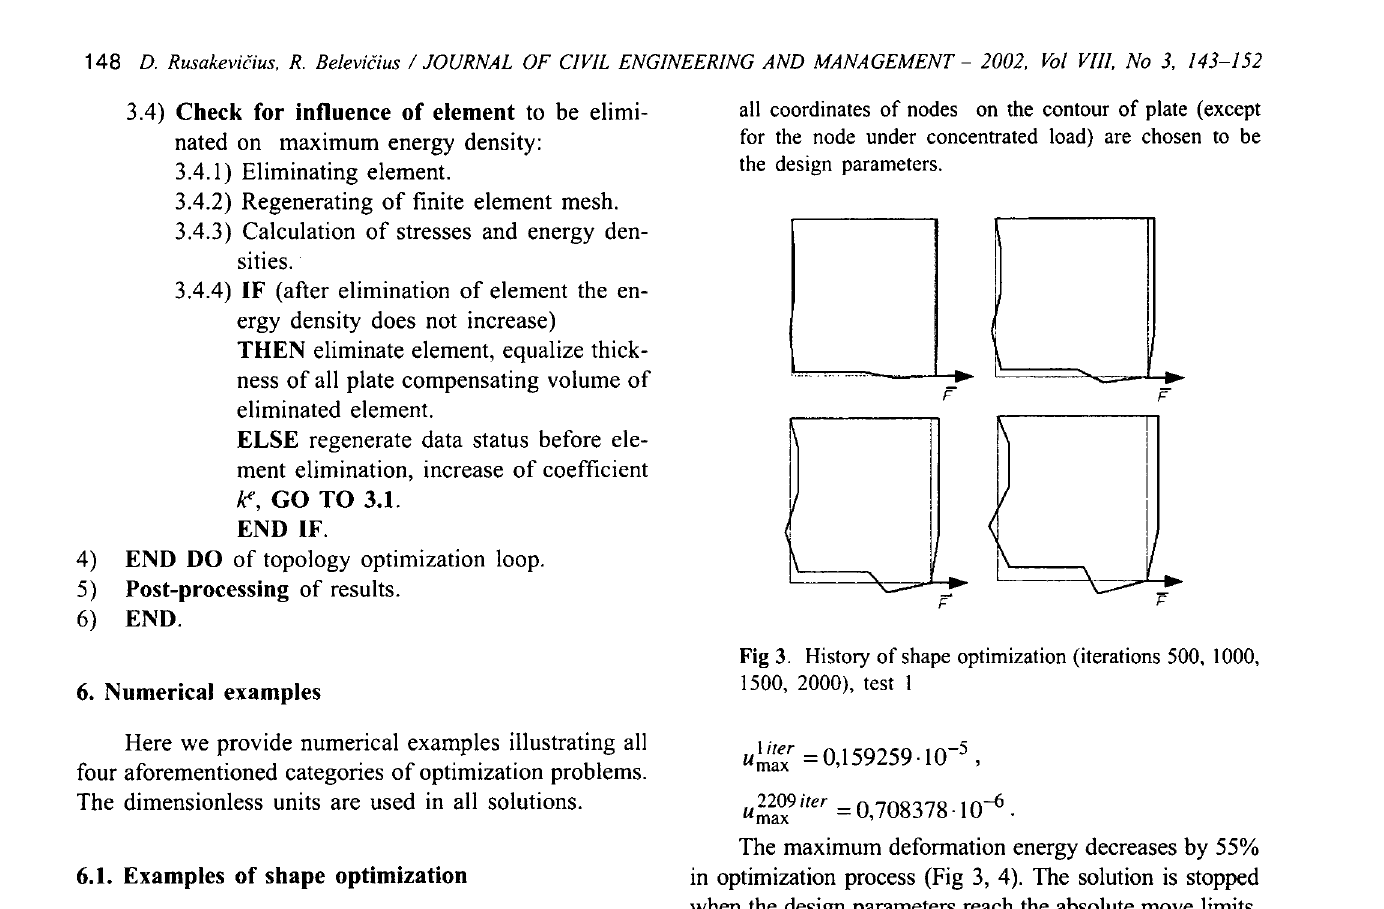
Fig 3. History of shape optimization (iterations 500, 1000, 1500, 2000), test I u~~~ = 0,159259-10- 5 , u~~~ 9 iter =0,708378·10-6. The maximum deformation energy decreases by 55% in optimization process (Fig 3, 4). The solution is stopped when the design parameters reach the absolute move limits. 1.75E-Cl5